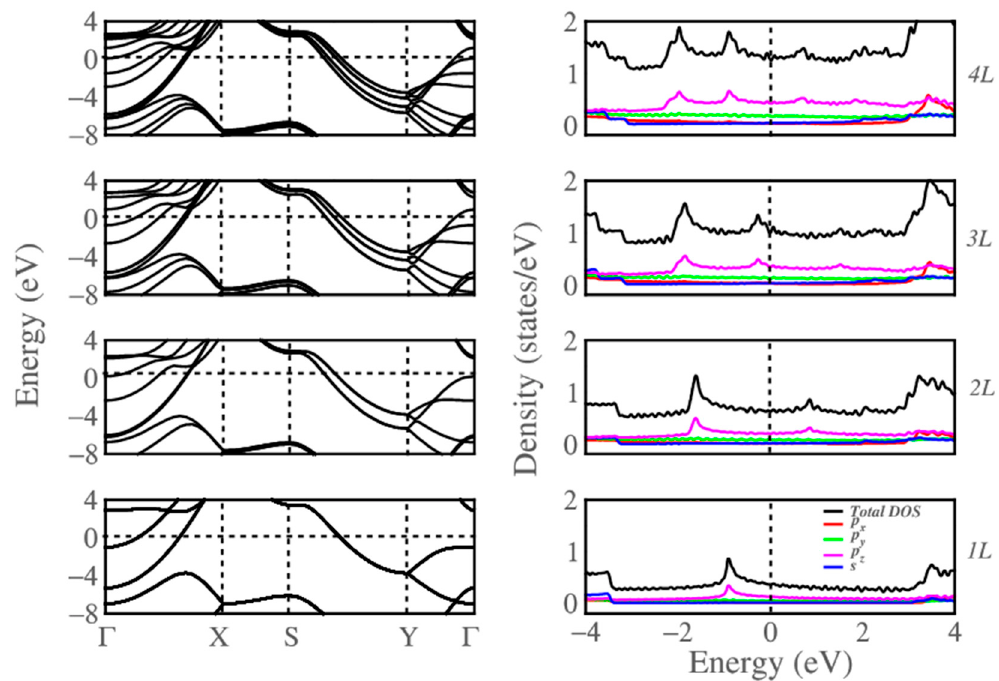
Figure 2. The calculated band structures and partial density of states for monolayer (1L), bilayer (2L), trilayer (3L), and quad-layer (4L) (bottom to top) borophene, respectively. Zero of the energy is taken to be the Fermi energy of the system.